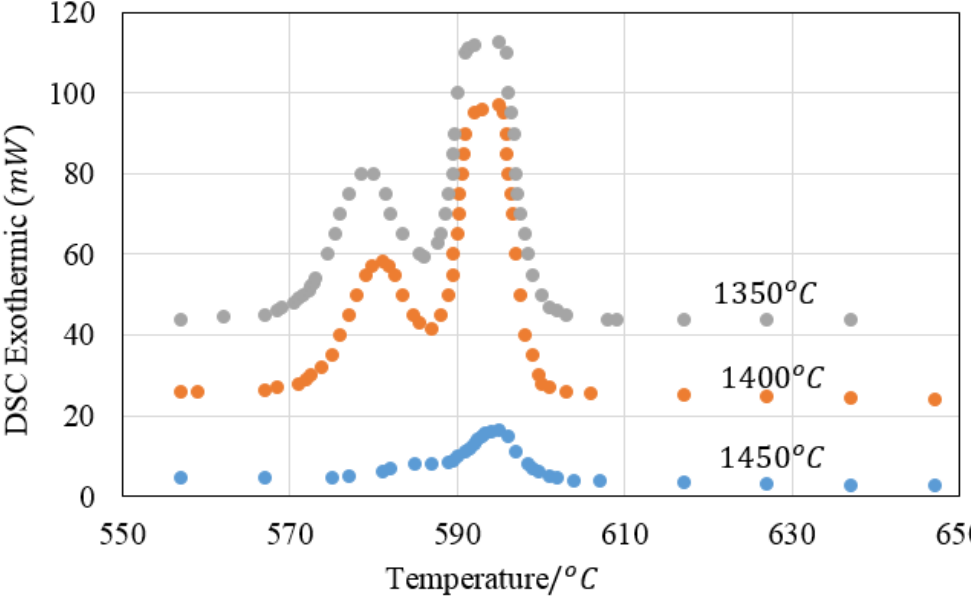
Figure 5. Effect excessive superheat on the degree of vitrification on as-cast